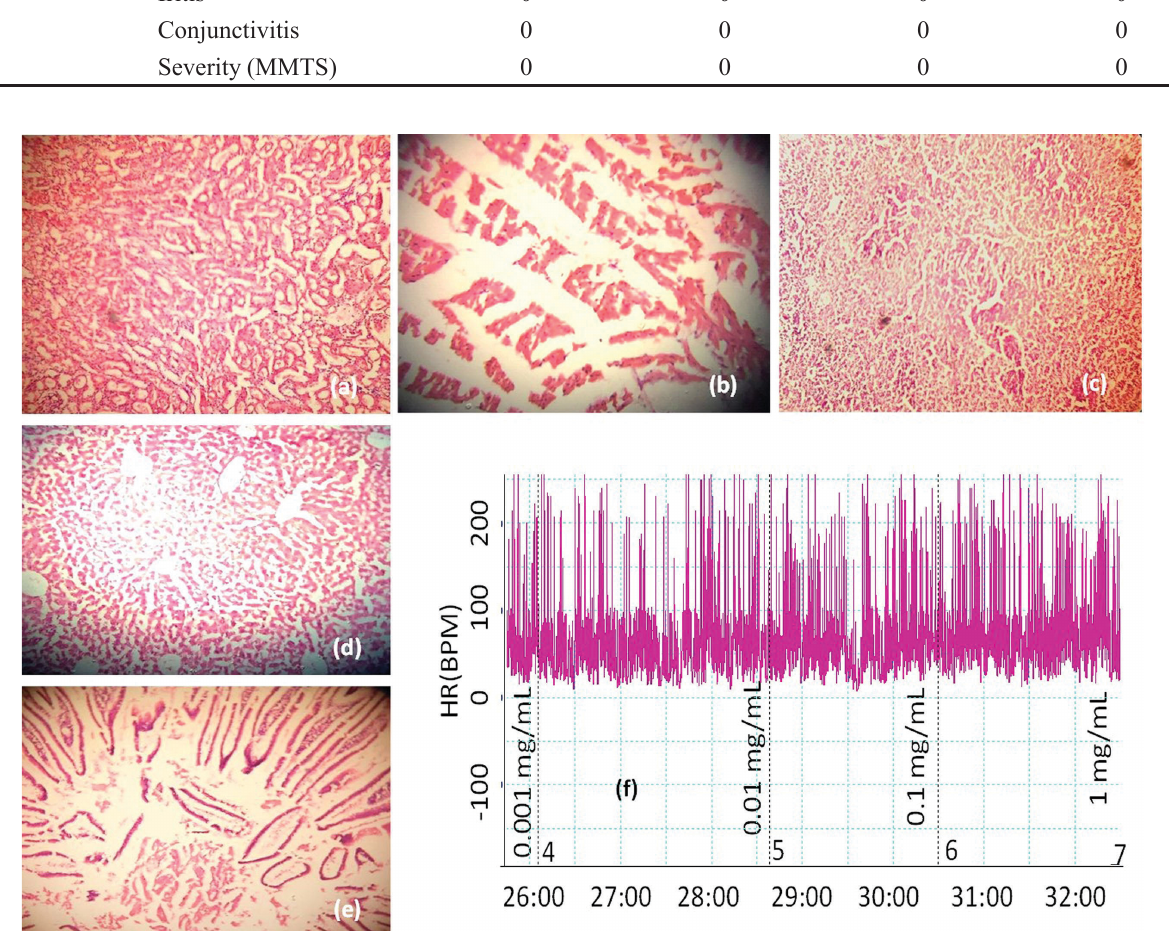
FIGURE 1 - Histopathology of various vital body organs of mice (a) intestine (b) heart (c) spleen (d) liver (e) kidney and (f) effect of various GXH concentrations on heart